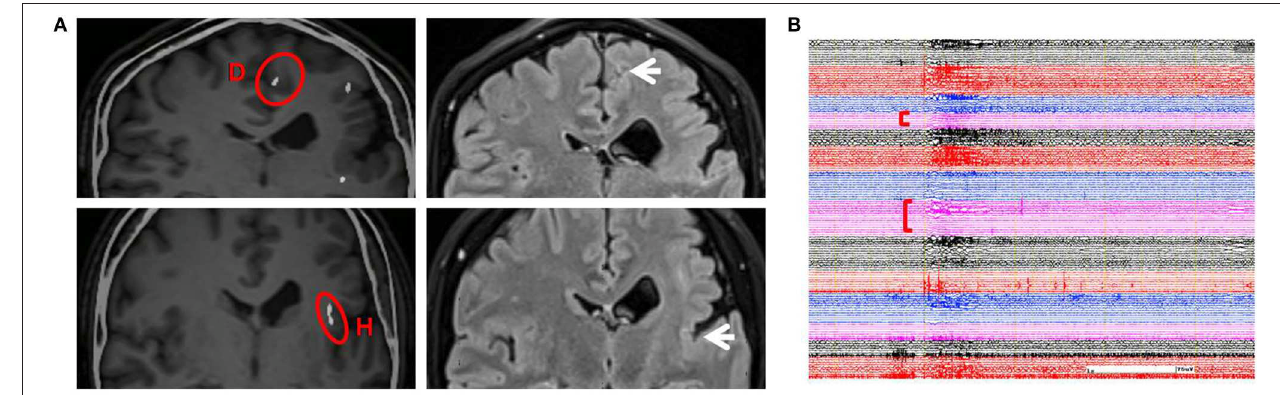
FIGURE 3 | (A) Illustration on the left shows early-onset electrode D (contacts 1–5) and H (contacts 9–15) in which RF-TC was performed first (highlighted with red circles). Illustration on the right shows sites of coagulation in the same region on an MRI image acquired 6 months after the first RF-TC (arrows on the right). The patient was free from startle seizures even when provoked by sudden unexpected sounds or other events during the following 2 weeks of monitoring. (B) The patient did not have a seizure when stimulated by a sudden unexpected sound; SEEG showed a similar pattern of a startle-induced seizure, yet there was no trace of discharges in electrodes D and H after RF-TC. RF-TC, radiofrequency